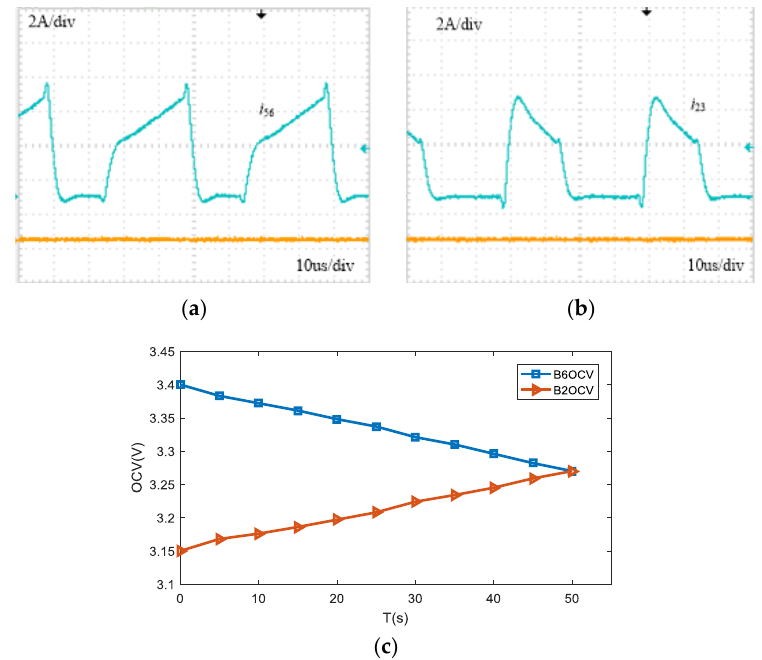
Figure 18. Key waveforms of Case 2: ( a ) current of L 56 ; ( b ) current of L 23 ; and ( c ) static balancing